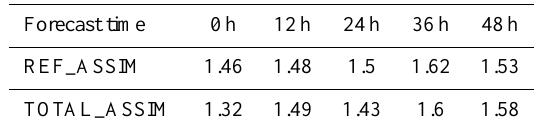
Table 2. The level of 2m temperature, RMSE of REF_ASSIM and TOTAL_ASSIM for forecast times 0, 12, 24, 36 and 48h, aver- age for the period of 10 to 25 April 2012. Stations considered are Hurghada, Luxor, Kosseir, Siwa, Wadi el Natrun, Cairo, Port Said and Ras Sedr in Egypt, and Ben Gurion airport, close to Tel Aviv in Israel.